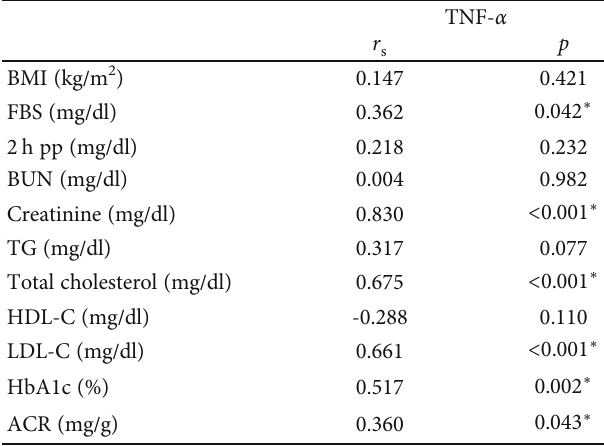
Figure 2: ROC curve for TNF- α to predict diabetic patients with albuminuria vs. diabetic patients without Table 2: Correlation between serum TNF- α levels and di ff erent parameters among DN.